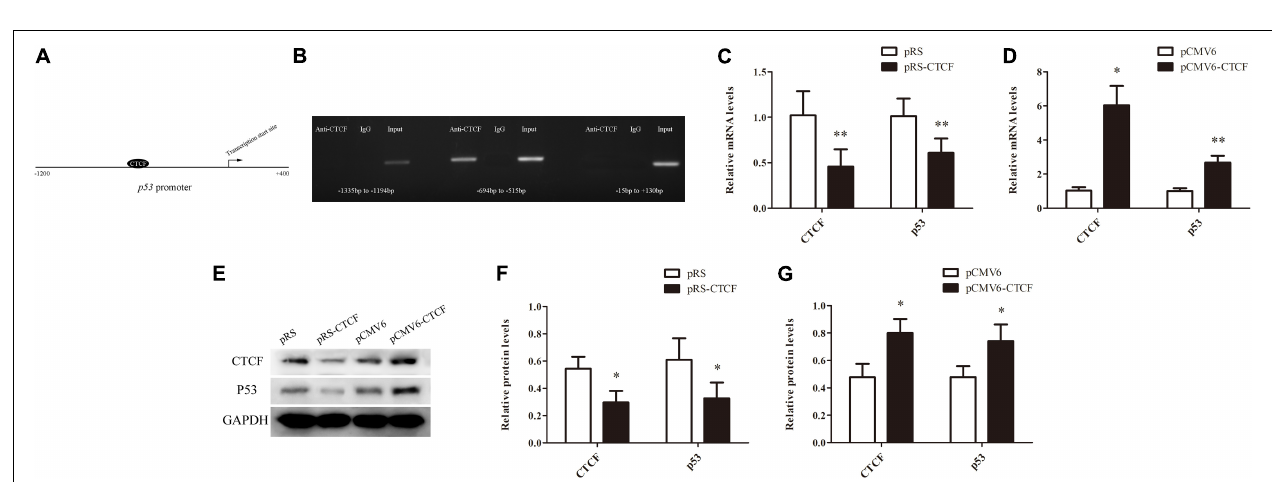
FIGURE 2 | CTCF is a key factor to promote p53 expression in CD4 + T cells. (A) Schematic diagram of the CTCF binding site in the p53 promoter region. (B) ChIP-PCR showing that CTCF binds to the promoter region ( − 694 to − 515) of p53 in T cells. (C , D) p53 mRNA levels in normal CD4 + T cells after CTCF silencing or overexpression. Data are mean ± SD from three independent experiments. (E) Representative Western blotting results for p53 protein expression in CD4 + T cells after CTCF silencing or overexpression. (F , G) Quantitative analysis of band intensities for p53 protein, normalized to GAPDH expression. Data are mean ± SD from three independent experiments. ( ∗ P < 0.05, ∗∗ P < 0.01).